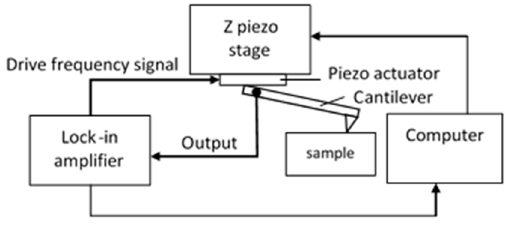
Figure 42. The contact resonance experimental setup realized on the Profilescanner.